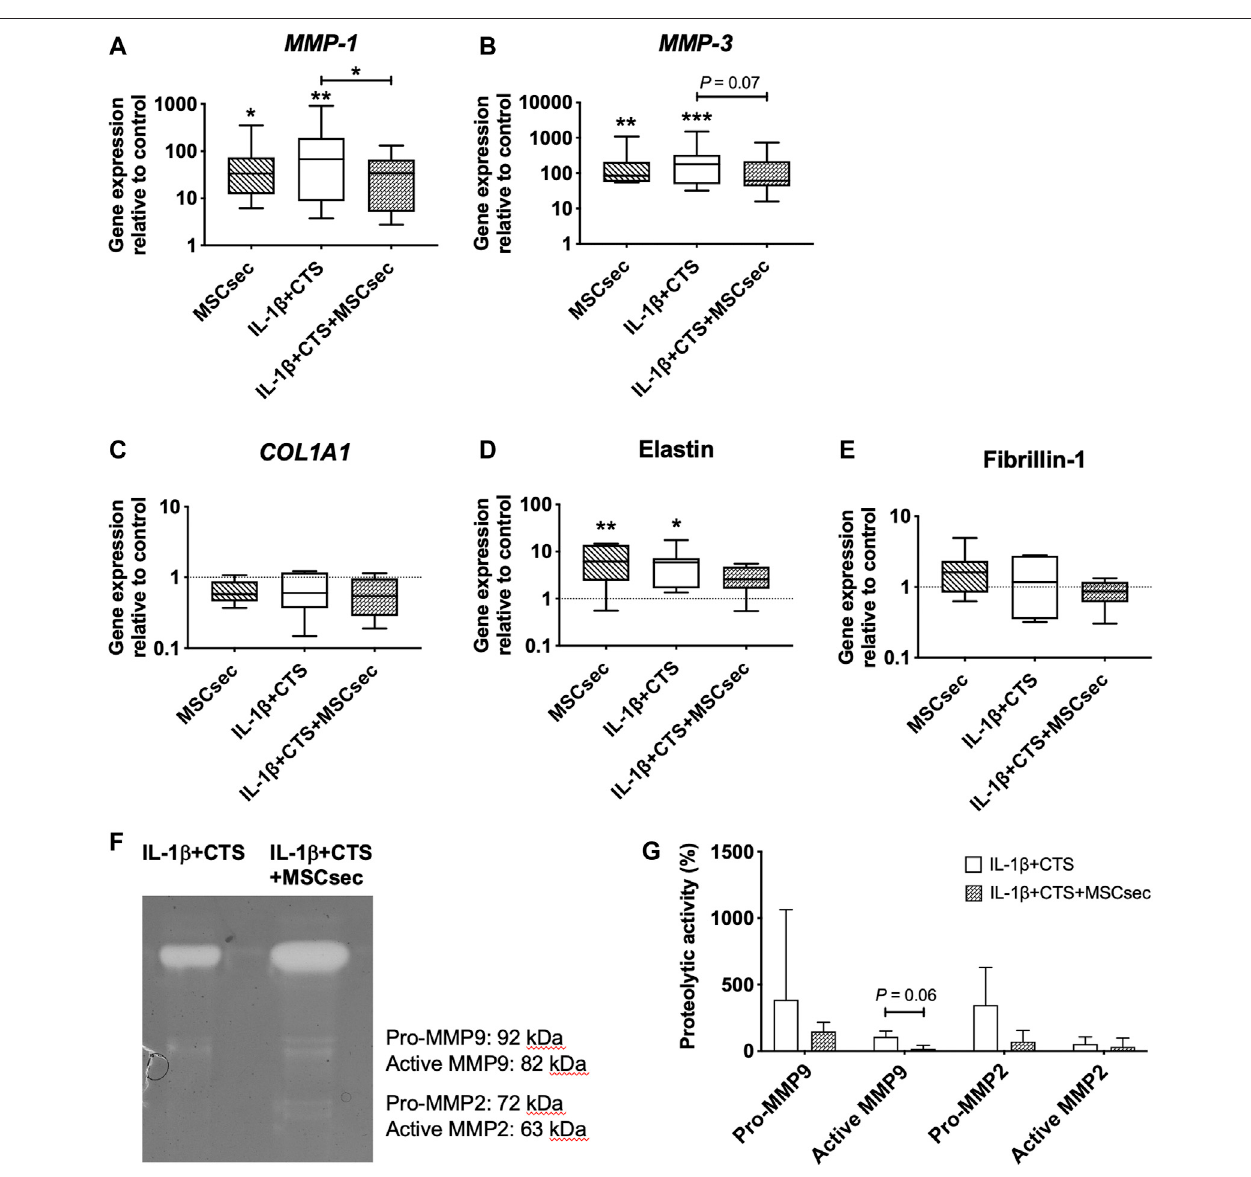
FIGURE 5 | Effect of MSC secretome on human AF cells stimulated with cyclic tensile strain (CTS) and IL-1 β (10 ng/ml) in MMPs and ECM proteins after 48 h. Relative mRNA expression of the matrix degrading enzymes (A) MMP-1 and (B) MMP-3 , and of ECM proteins (C) COL1A1 , (D) elastin, and (E) fi brillin-1. Results were normalized to the expression level of GAPDH and unstimulated cells. n (cid:1) 7, * p < 0.05, ** p < 0.01. (F) MMP activity in AF cultures media, determined by gelatin zymography (G) Quanti fi cation of MMP-2 and MMP-9 activity by densitometry ( n (cid:1) 3).